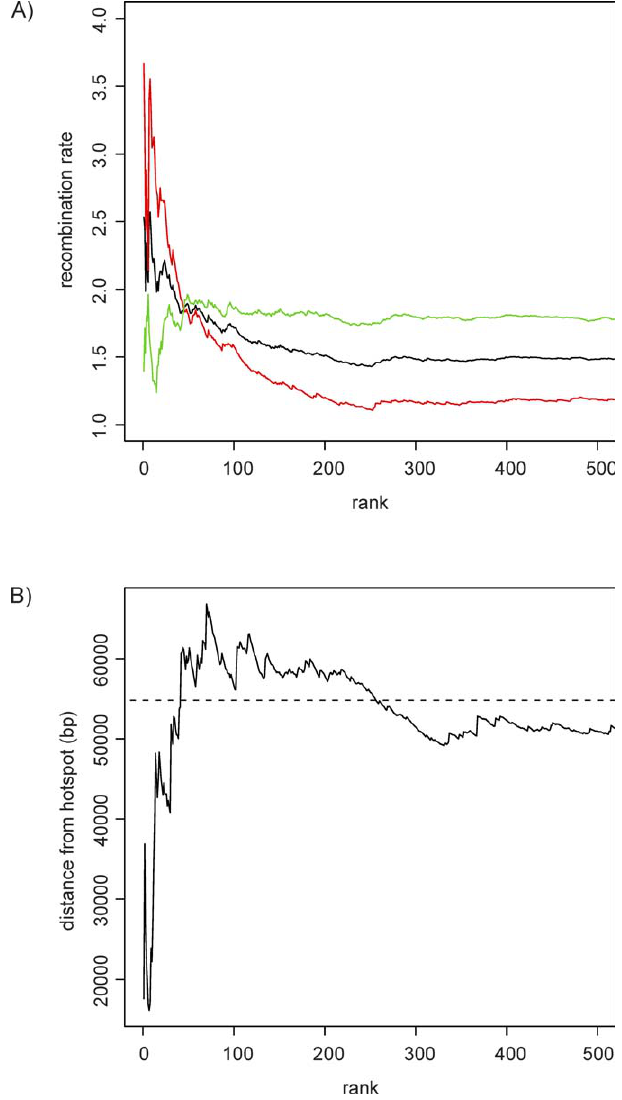
Figure 4. Cumulative Average Human Recombination Rate in the Regions Surrounding the Most Accelerated Exons (A) Cumulative average male (red), female (green), and sex-averaged (black) recombination rates. (B) Cumulative average distance to the nearest recombination hotspot. The dashed line represents the average for the entire